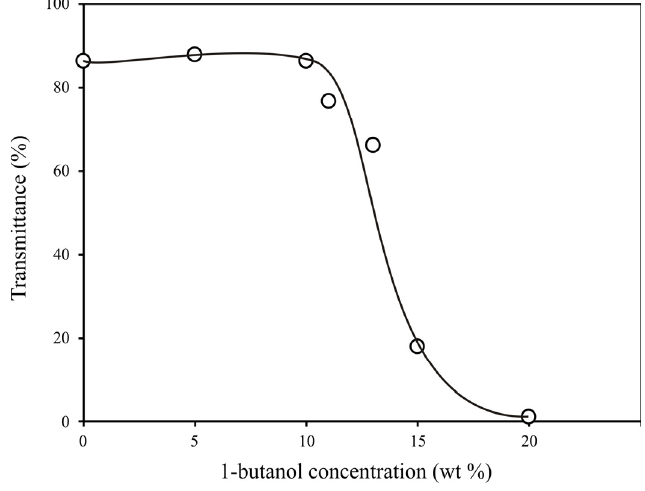
Figure 12. Light transmission of porous polyOCM-2 monoliths at λ = 550 nm depending on the concentration of 1-butanol in the initial PPC.